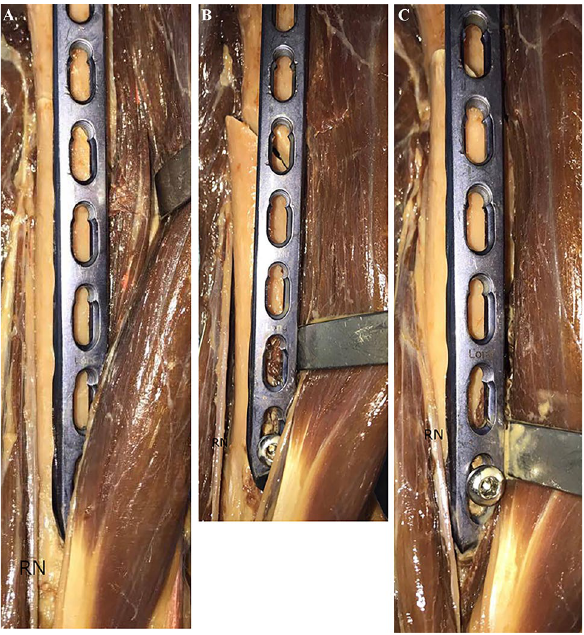
Figure 5. Rotation tests of the RN. ( a ) Neutral position; ( b ) external rotation; ( c ) internal